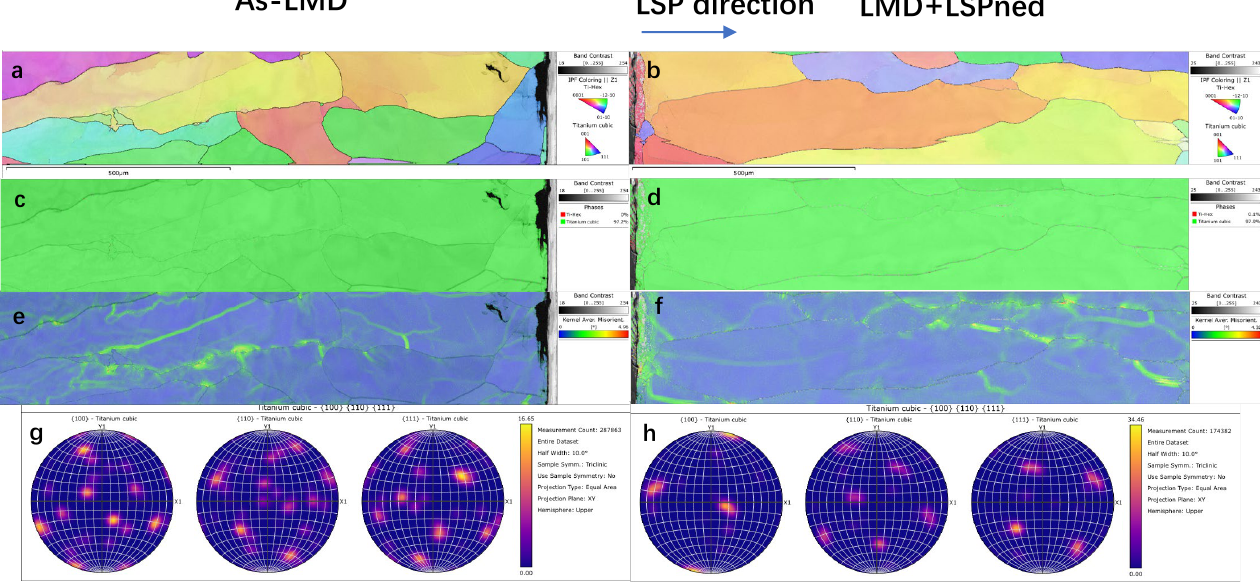
Figure 6. EBSD analysis of as-deposited area of as-LMD and LMD+LSPned samples: ( a , b ) IPF Z mappings; ( c , d ) phase mappings; ( e , f ) KAM mappings; ( g , h ) pole figures.